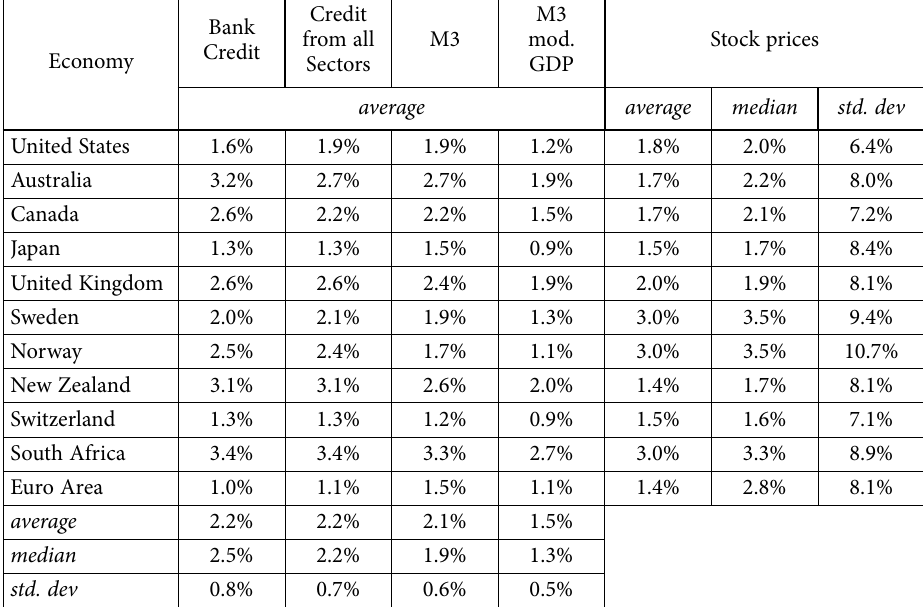
Table 2. Quarterly growth rates of credit, broad money and stock prices between 1Q 1970 and 4Q 2016 (source: own work) Bank Economy